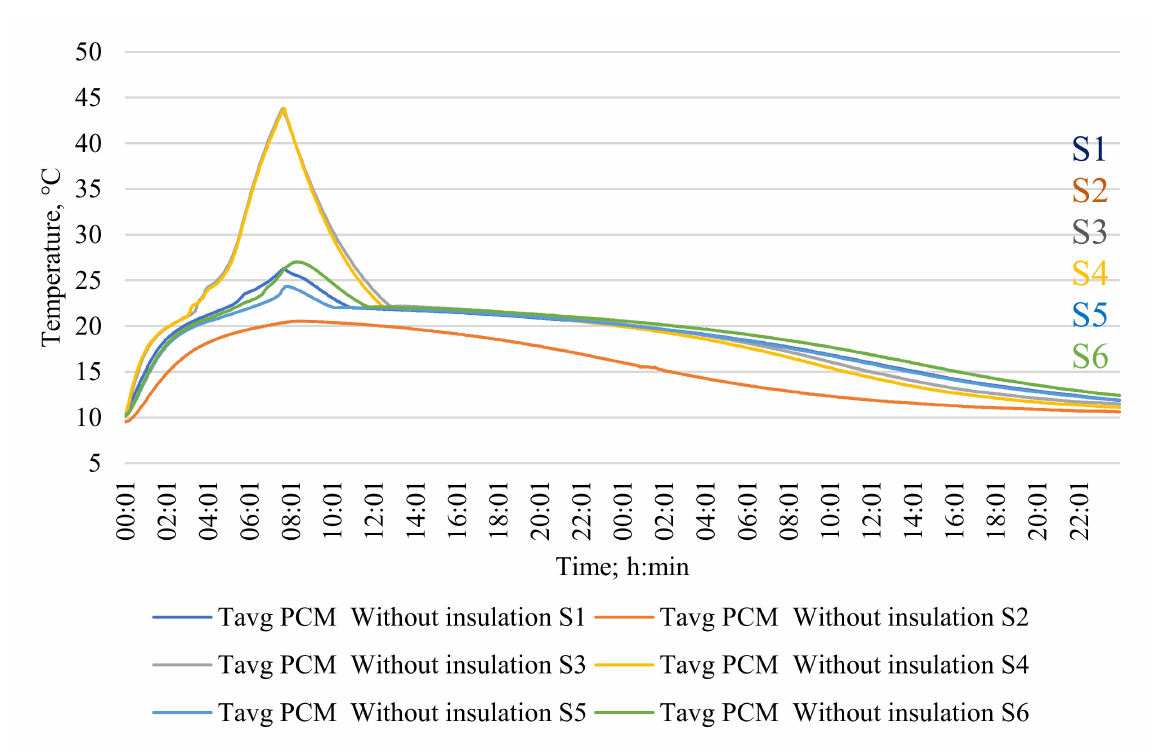
Figure 9. The average temperature in phase-change material in six setups without insulation applied at